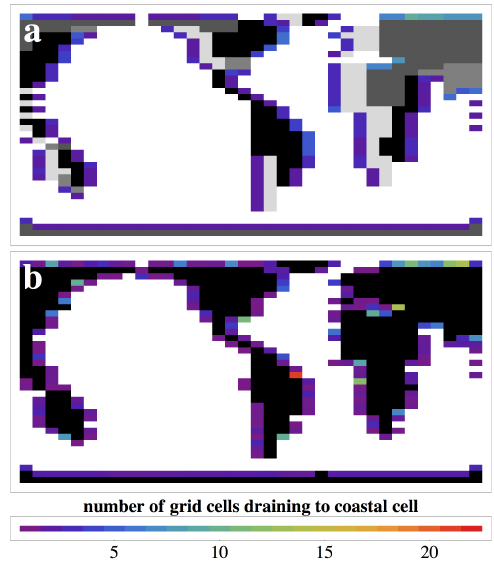
Fig. 14. River drainage to the coastal ocean. Using 2 different schemes: a. ’roof’ routing only (scheme 1); b. detailed topographical routing and roof routing (scheme 2). In a. routing directions are shown: North (dark grey), South (middle grey), East (black), West (light grey). See text for further explanation.